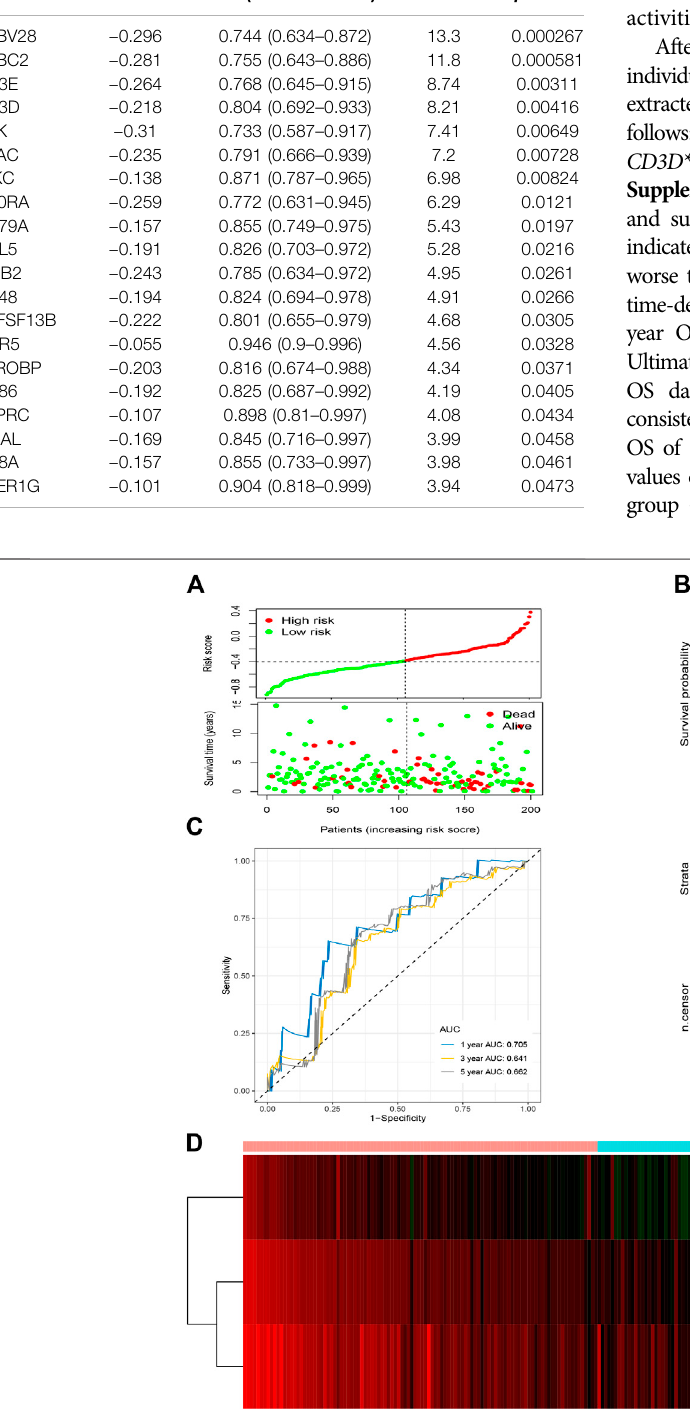
Frontiers in Molecular Biosciences |